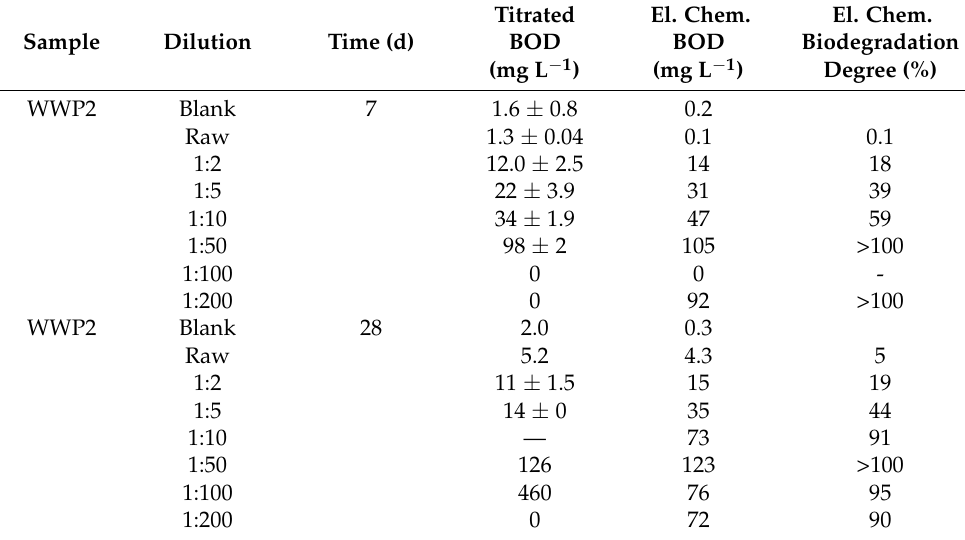
Table 4. The sample, dilution factor, and BOD values and the calculated biodegradation degrees of the WWP2 sample measured with titration and electrochemical probe.